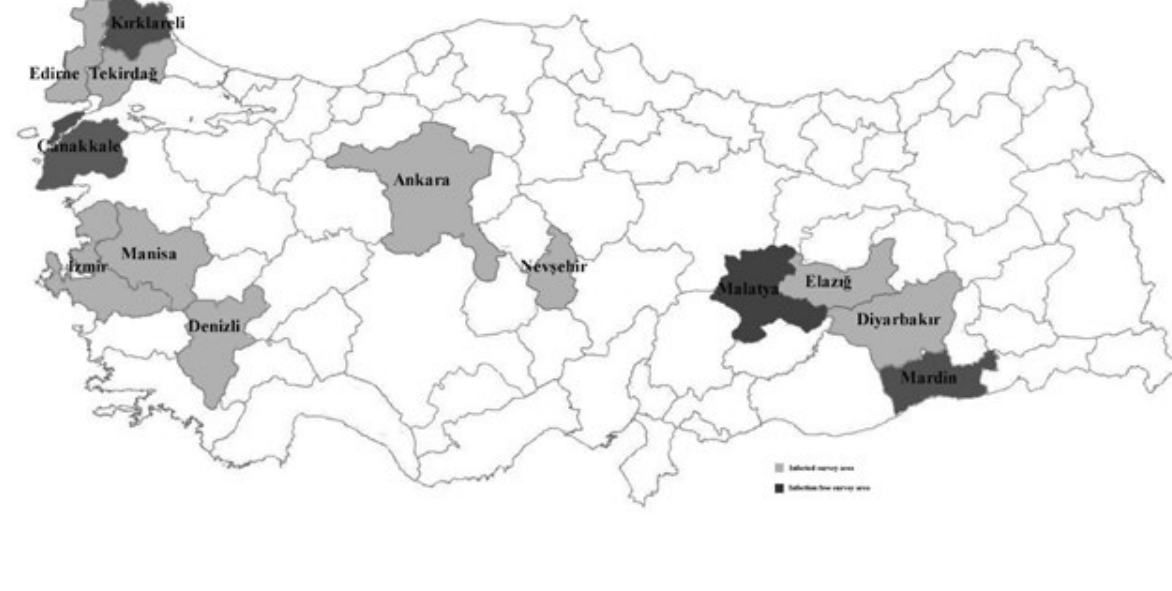
Figure 1. Turkish provinces surveyed for the presence of Rhizobium vitis in vineyards.